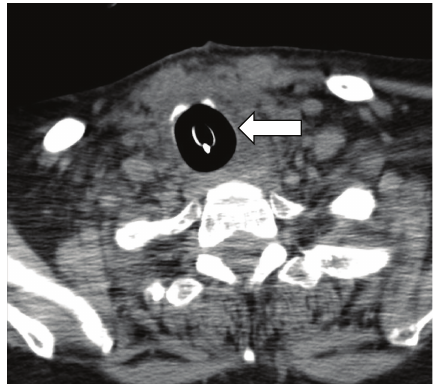
Figure 4: Postthyroidectomy